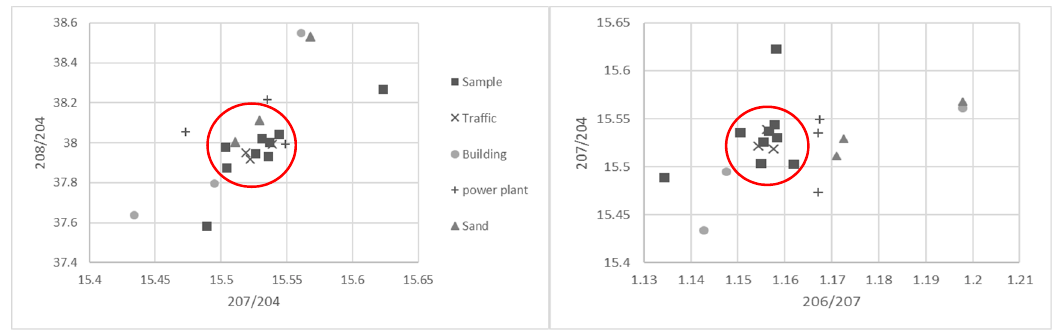
Figure 4. Pb isotope plots for samples and pollution sources (samples in red circles have similar sources).